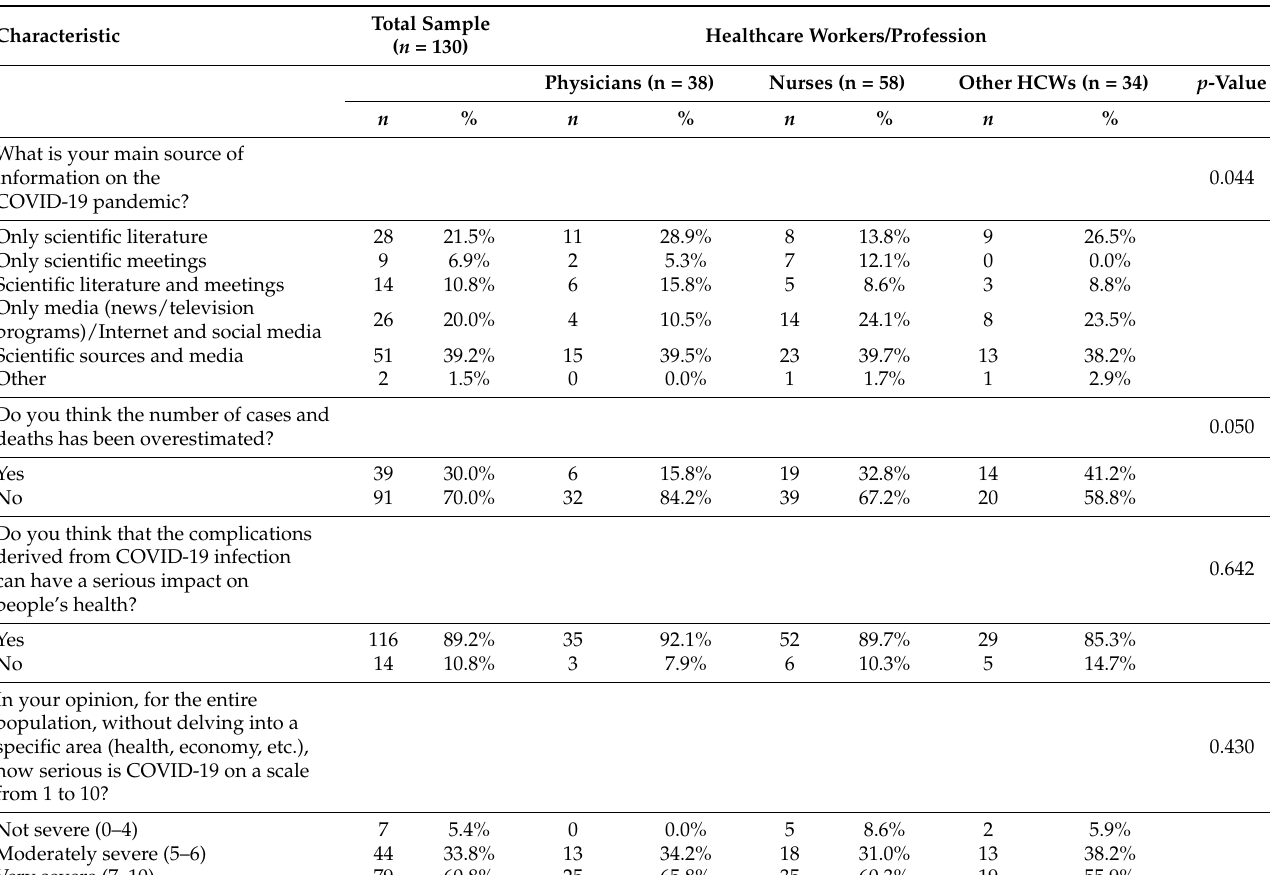
Table 3. Sources of information about the pandemic and its perception among the participants.